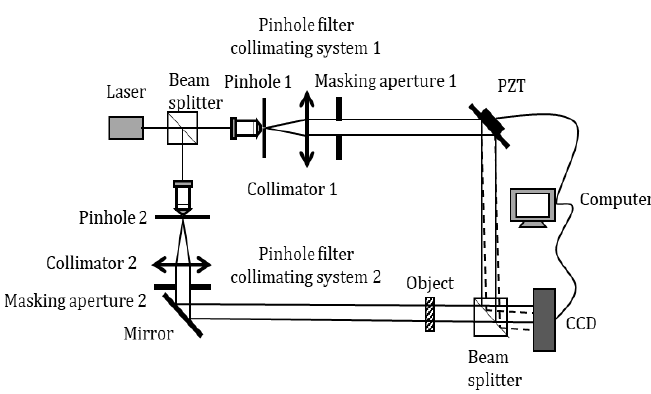
Figure 5. Three-step generalized phase-shifting interferometry (TGPSI) recording setup with a slight-tilt reference, where the dotted lines illustrate the tilted reference actually used. A piezoelectric transducer (PZT) is used as a phase